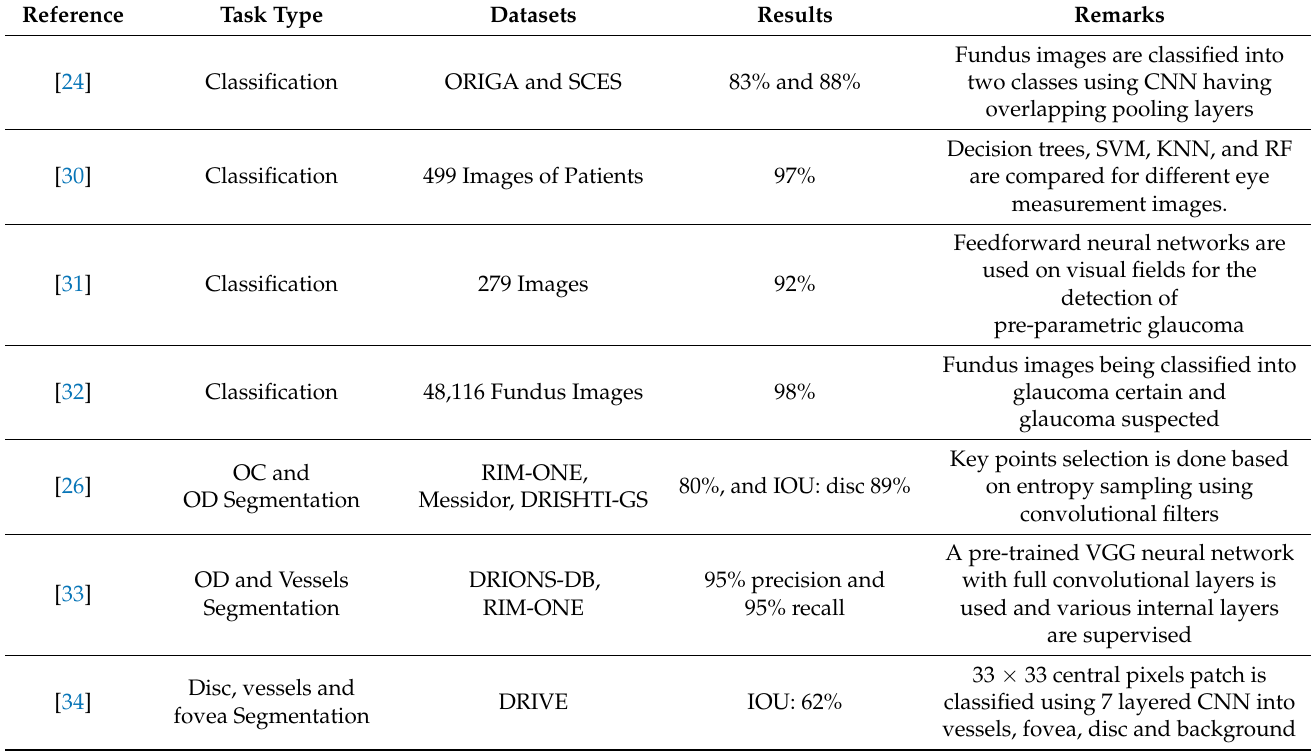
Table 1. Summary of the existing Techniques for Glaucoma